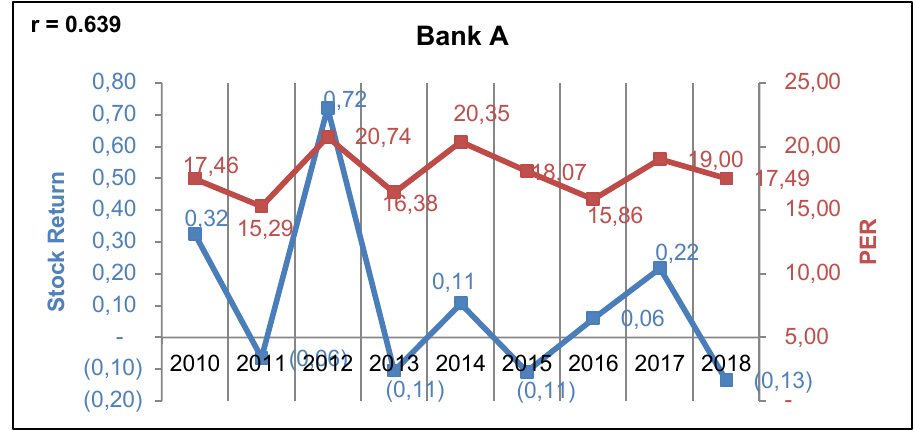
Figure 1: For Bank A